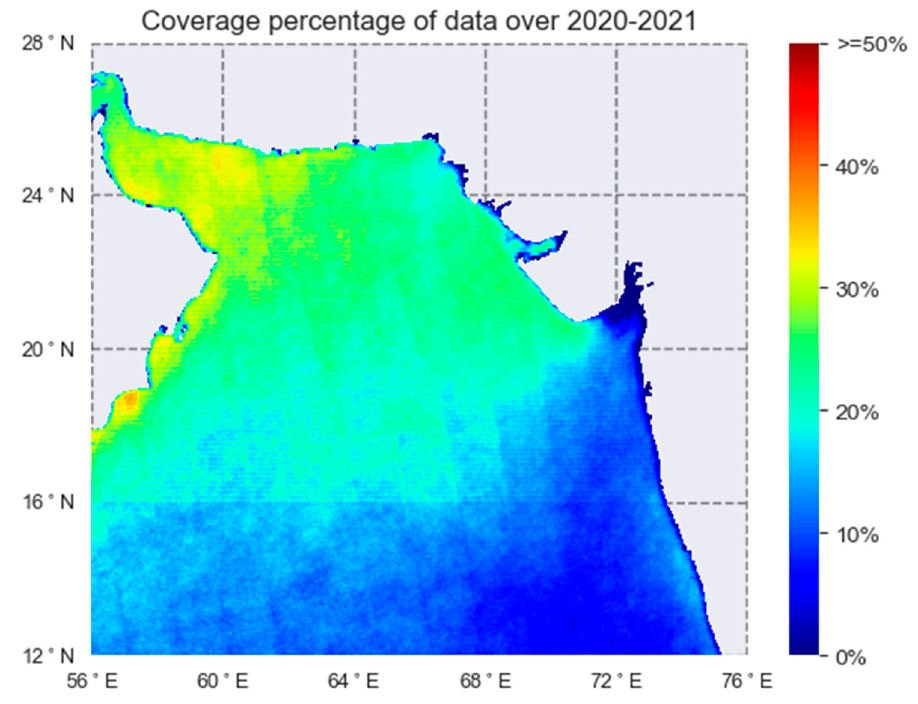
Figure 2. Percentages of Chl − a data coverage for the NAS from 2020 to 2021. The gray area represents the land.